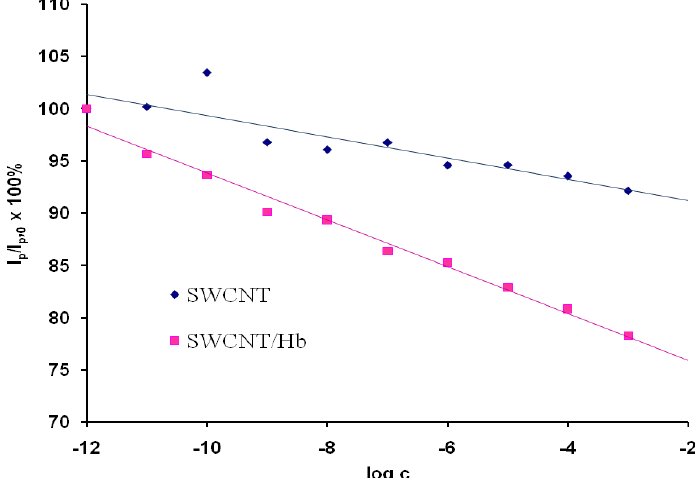
Figure 3. The ratio of OSWV peak current in the presence of different concentration of ) to that in the absence of acrylamide (I ) as a function of the acrylamide acrylamide (I p p,0 concentration. The currents were measured at the peak potential in OSWV curves in the solution with no analyte E . Results obtained for electrodes modified with SWCNT, p,0 E =46 mV, n=4, 2.2<SD<7.7 ( ♦ ) and SWCNT/Hb, E =44 mV, n=3, 0.9<SD<4.4 ( ■ p,0 p,0